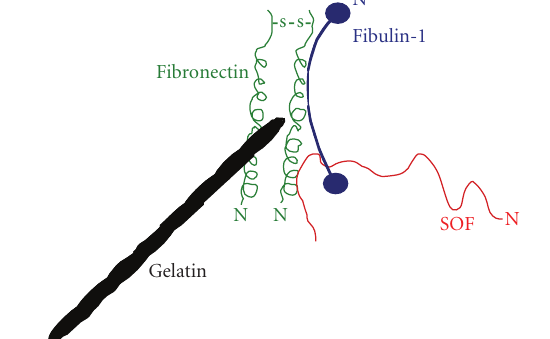
Figure 9: Model of quaternary complex between gelatin, fi- bronectin, fibulin-1, and SOF. Although SOF can bind to fibulin-1 independently of fibronectin, mixed binding experiments indicated that SOF binds much better to a complex of fibulin-1, fibronectin, and gelatin. Such complexes are possible because fibronectin contains independent binding sites for gelatin (collagen), fibulin- 1, and SOF. Also SOF can react with fibulin-1 and fibronectin via independent binding domains. It is postulated that interactions between gelatin and fibronectin induces a conformational change in fibronectin that facilitates interactions with other ligands and SOF and enhances adhesion of streptococci to host surfaces. Reproduced from [49] with